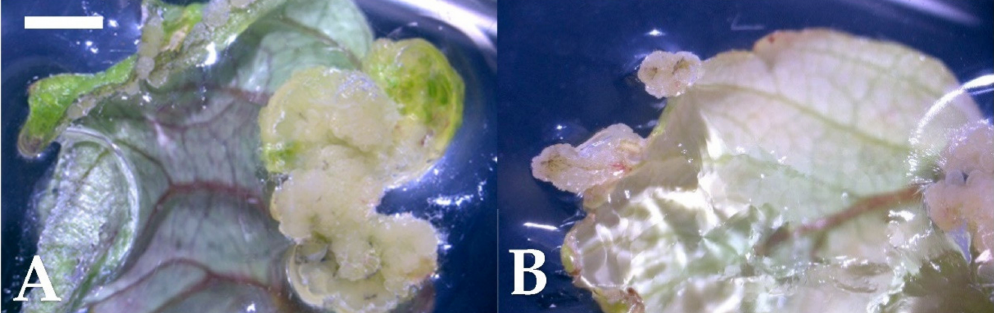
Figure 1. Callus induction from the leaf culture of strawberry after a 4-week culture (bar). ( A ) Thidiazuron (TDZ) 2.27 µ M and 2,4-dichlorophenoxyacetic acid (2,4-D) 0.45 µ M combination (1 mm); ( B ) TDZ 4.54 µ M and 2,4-D 2.27 µ M combination (1